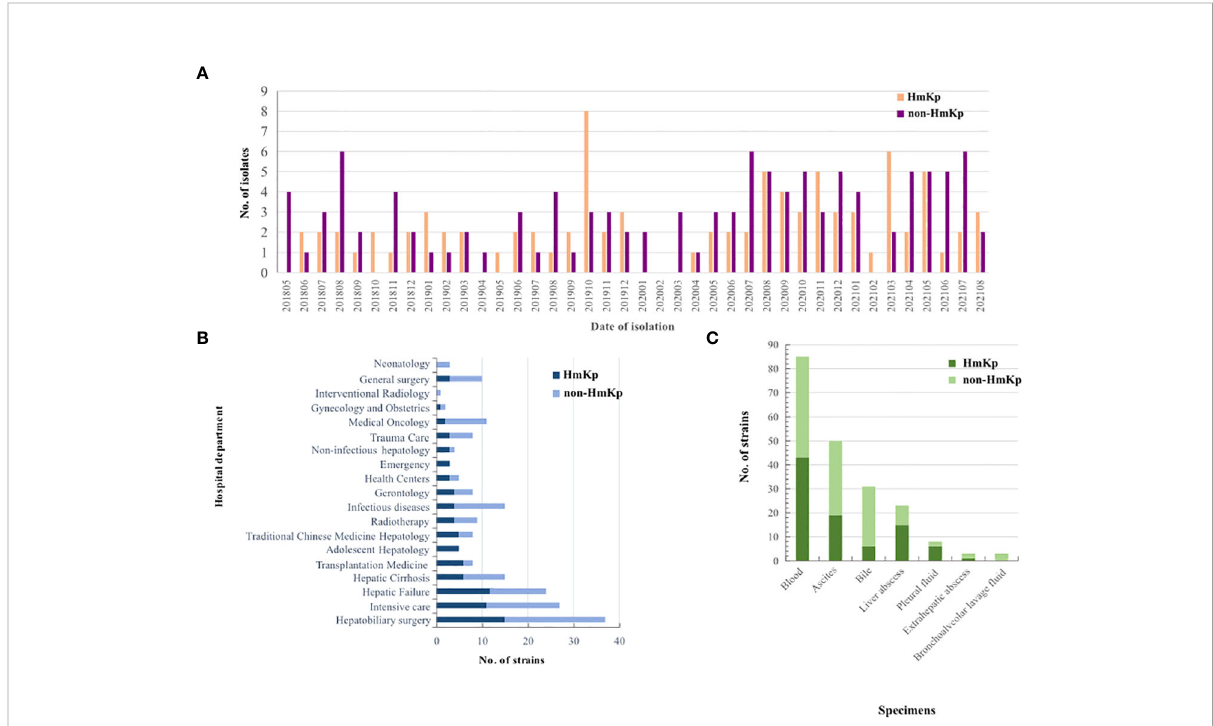
FIGURE 1 Clinical distributions of HmKp and non-HmKp isolates (A) Chronological distribution of HmKp and non-HmKp isolates. (B) Frequency of HmKp and non-HmKp isolates in hospital departments. (C) Distribution of HmKp and non-HmKp isolates by clinical